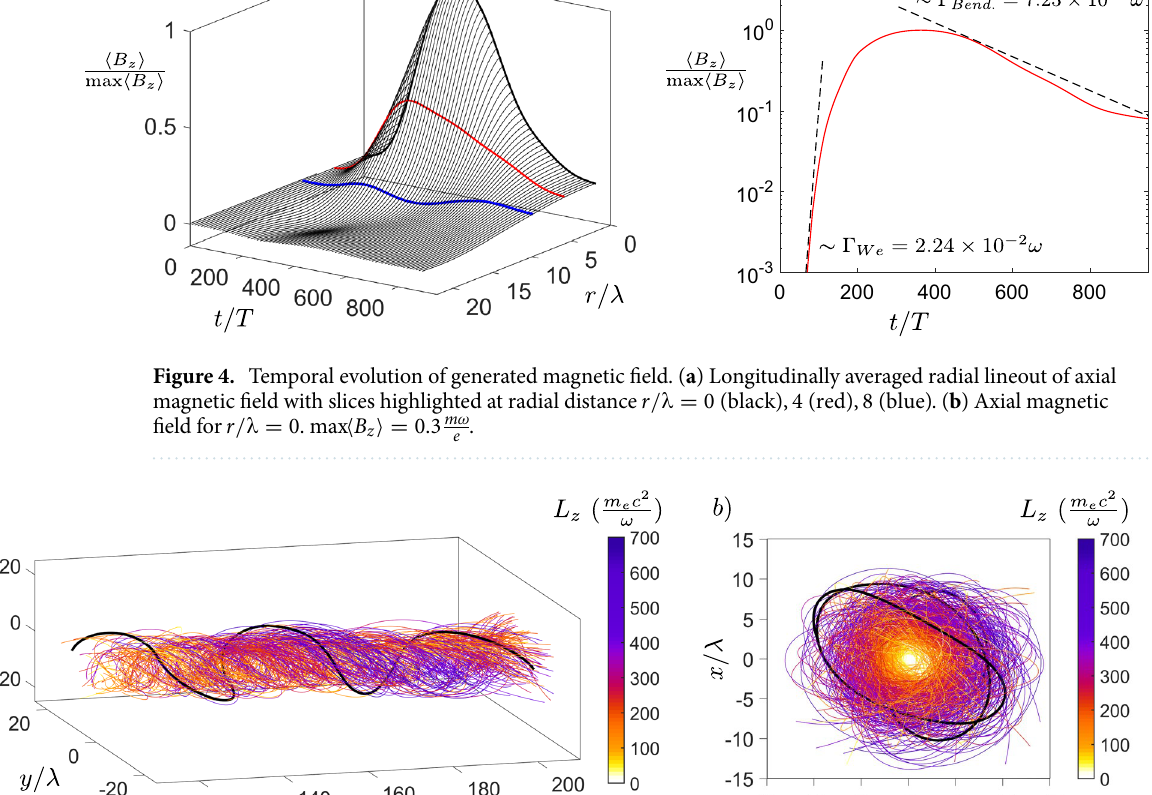
Figure 5. Electron trajectories generating axial and azimuthal magnetic fields. ( a ) Longitudinal angular momentum evolution with a z-direction view ( b ) shown in color, where m e c reveals the large absorption of right-handed photon spin angular momentum S z curve highlights a single electron trajectory with angular momentum L z